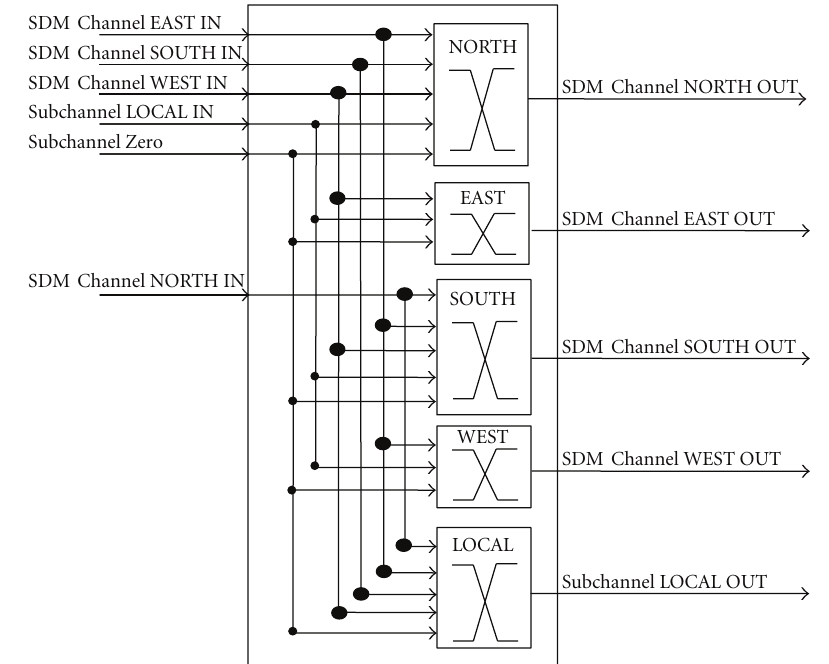
Figure 18: SDM-based circuit-switched subrouter.